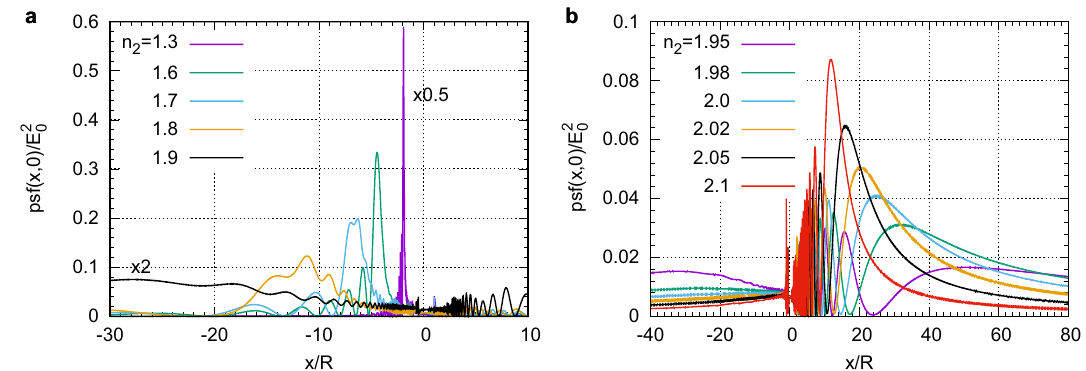
628 ) and a point source at x 100 ( kR = =